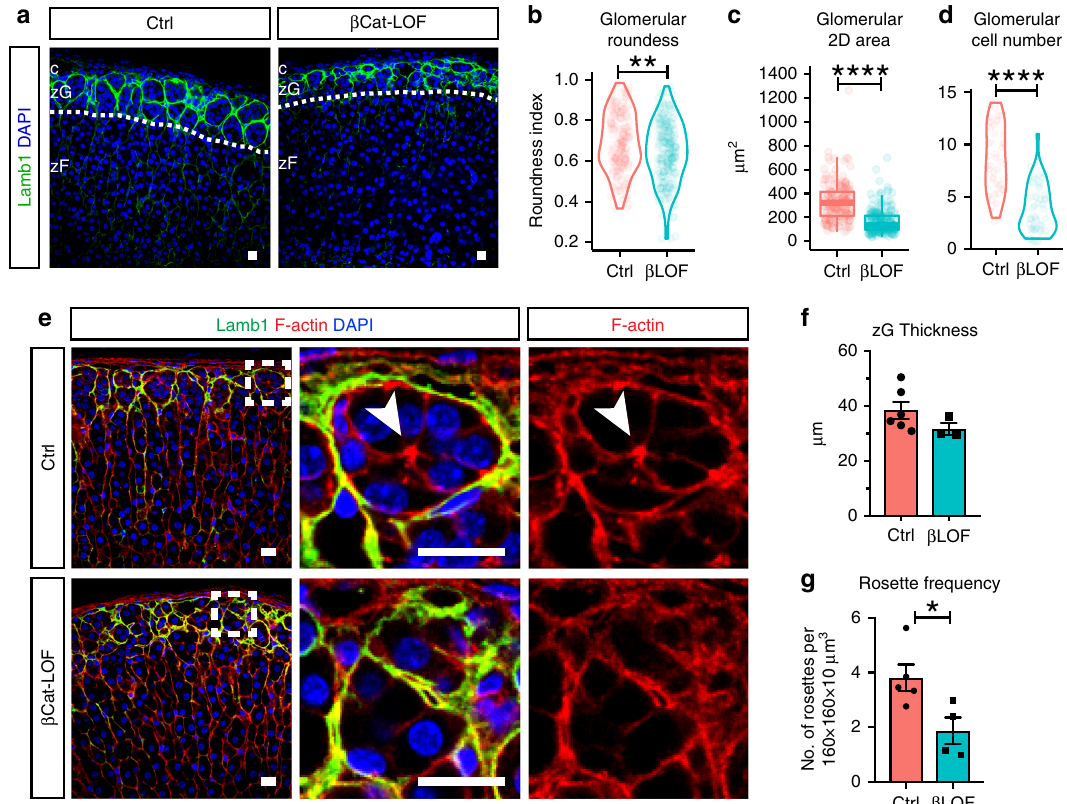
Fig. 4 β -catenin deletion leads to disrupted rosette and glomerular morphology. a Lamb1 staining (green) showing glomerular morphology in β -catenin loss-of-function ( β LOF) adrenals compared to controls (Ctrl). DAPI (blue) marks nuclei. Dotted line demarcates the zG/zF boundary. c capsule, zG zona glomerulosa, zF zona fasciculata. b Measurement of glomerular roundness. Mann – Whitney ’ s nonparametric test, ** P < 0.01. c Measurement of glomerular cross-sectional area. Mann – Whitney ’ s nonparametric test, **** P < 0.0001. For b and c , at least four animals (2 females and 2 males) and 30 glomeruli per animal were examined. d Measurement of glomerular cell number. Mann – Whitney ’ s nonparametric test, **** P < 0.0001. Four mice per group and at